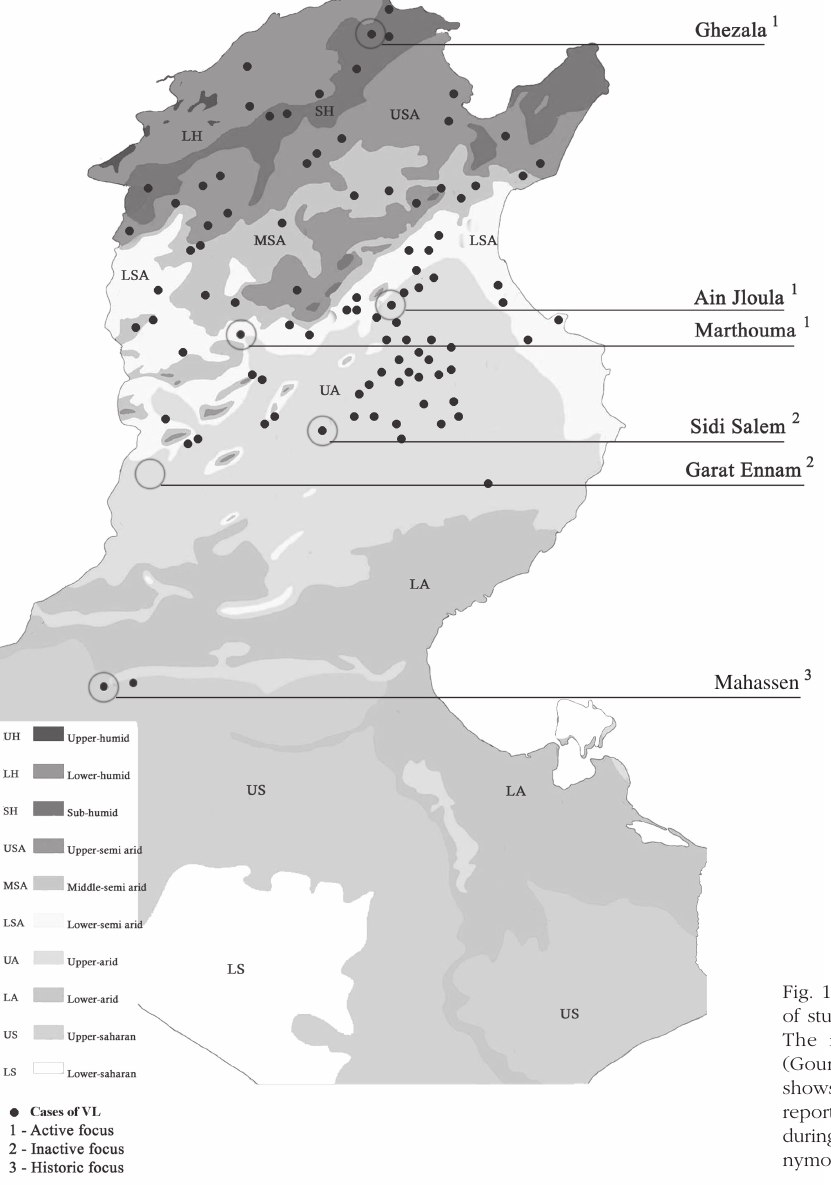
Fig. 1. – Geographical and bioclimatic situations of studied VL foci. The map reproduces the bioclimatic stages (Gounot & Le Houerou, 1967 in Nabli, 1989) and shows the geographical distribution of VL cases reported by the Directory of Primary Health Care during the season of transmission 2001-2002 (Ano- nymous,